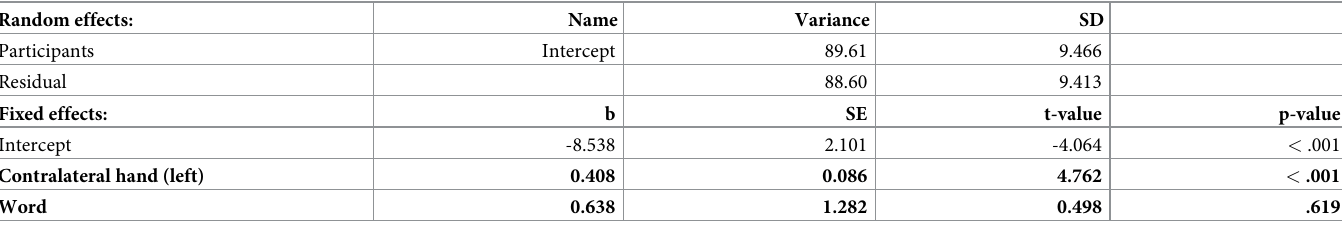
Table 15. Model 3.5. Effect of Direction on the right grip force (after controlling for the contralateral force) in the time window 810–890 ms (Experiment 3). Random